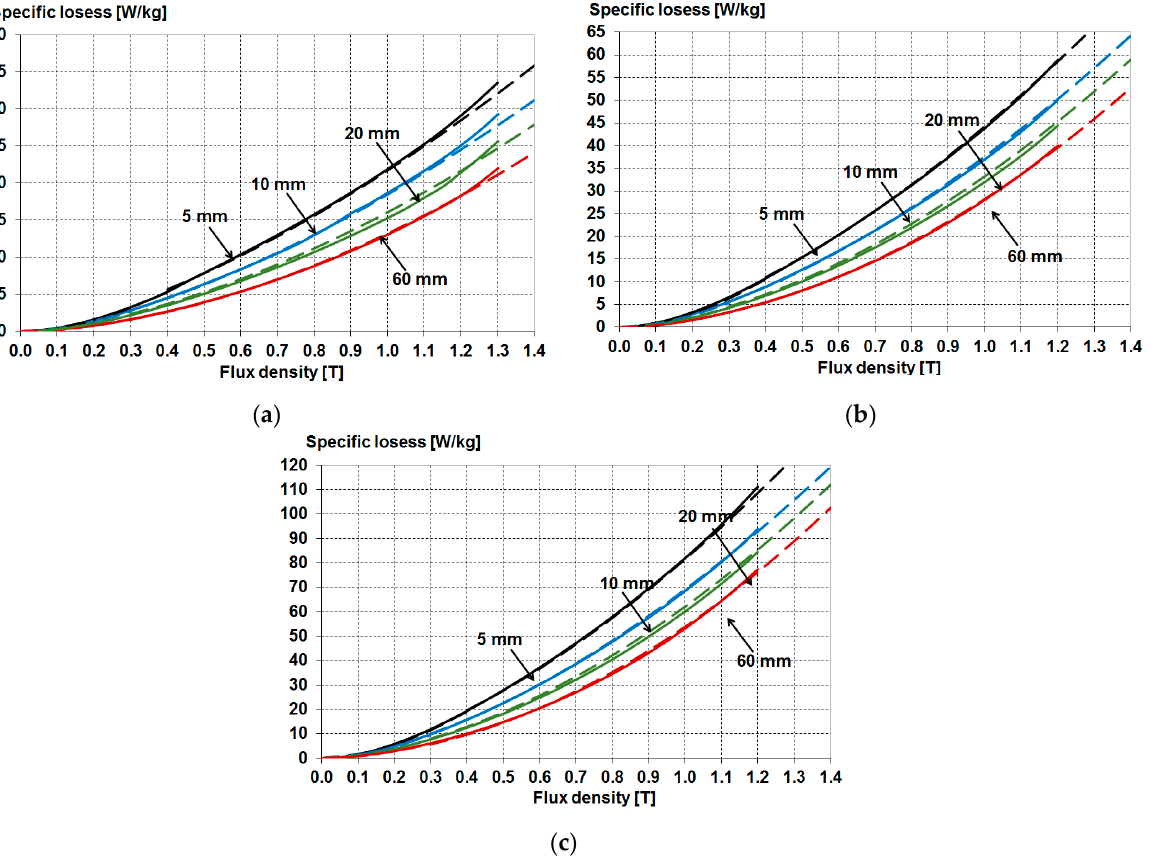
Figure 23. Measured and approximated loss characteristics of the M 270-35A sheet for various widths of laser-cut sheet samples at the frequency of 300 Hz ( a ), 500 Hz ( b ), 750 Hz ( c ); (measured— solid line, estimated—dashed line).